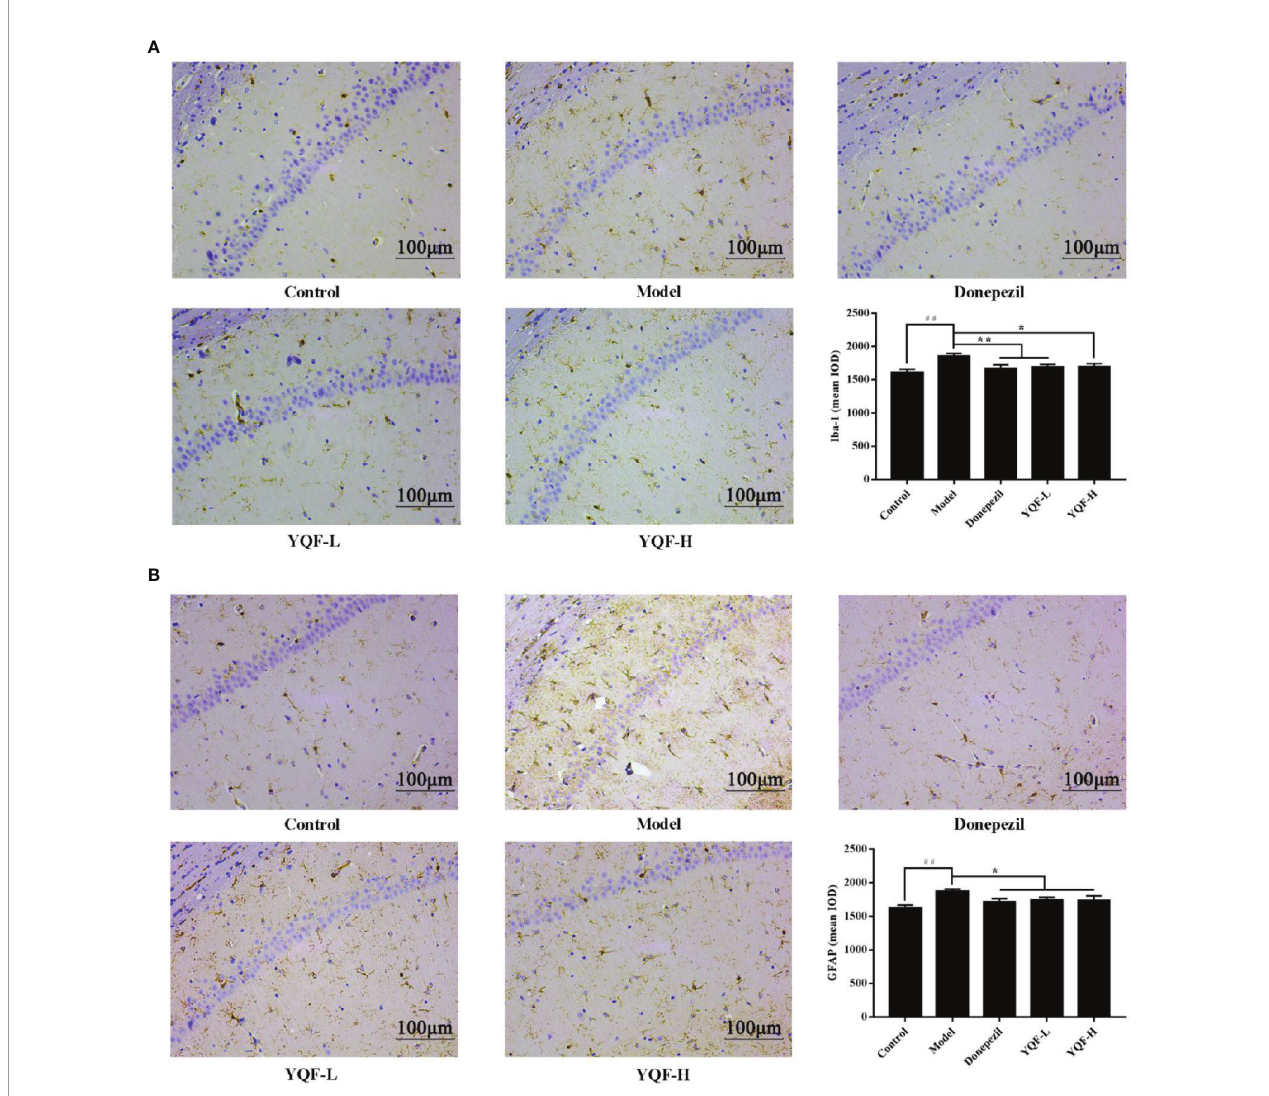
FIGURE 3 | Iba-1 and GFAP expression were detected by immunehistochemistry. (A) Iba-1 expression in aged rats. (B) GFAP expression in aged rats. The data are expressed as mean ± SEM, n = 5. ## p < 0.01, compared with control group; * p < 0.05, ** p < 0.01, compared with Model